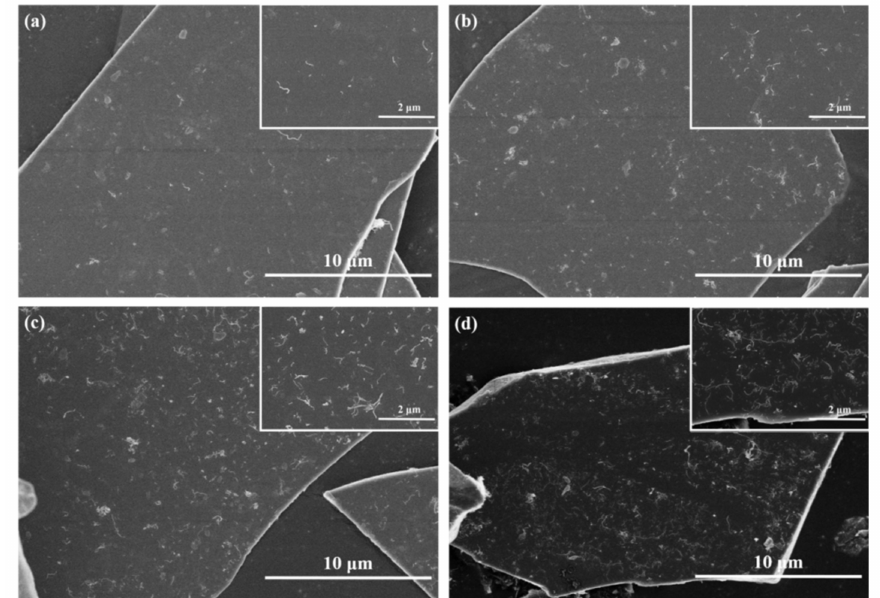
Figure 2. SEM images of basalt flakes modified with CNTs in di ff erent mass fractions. ( a ) 0.1 CNT-BF; ( b ) 0.3 CNT-BF; ( c ) 0.5 CNT-BF; ( d ) 0.7